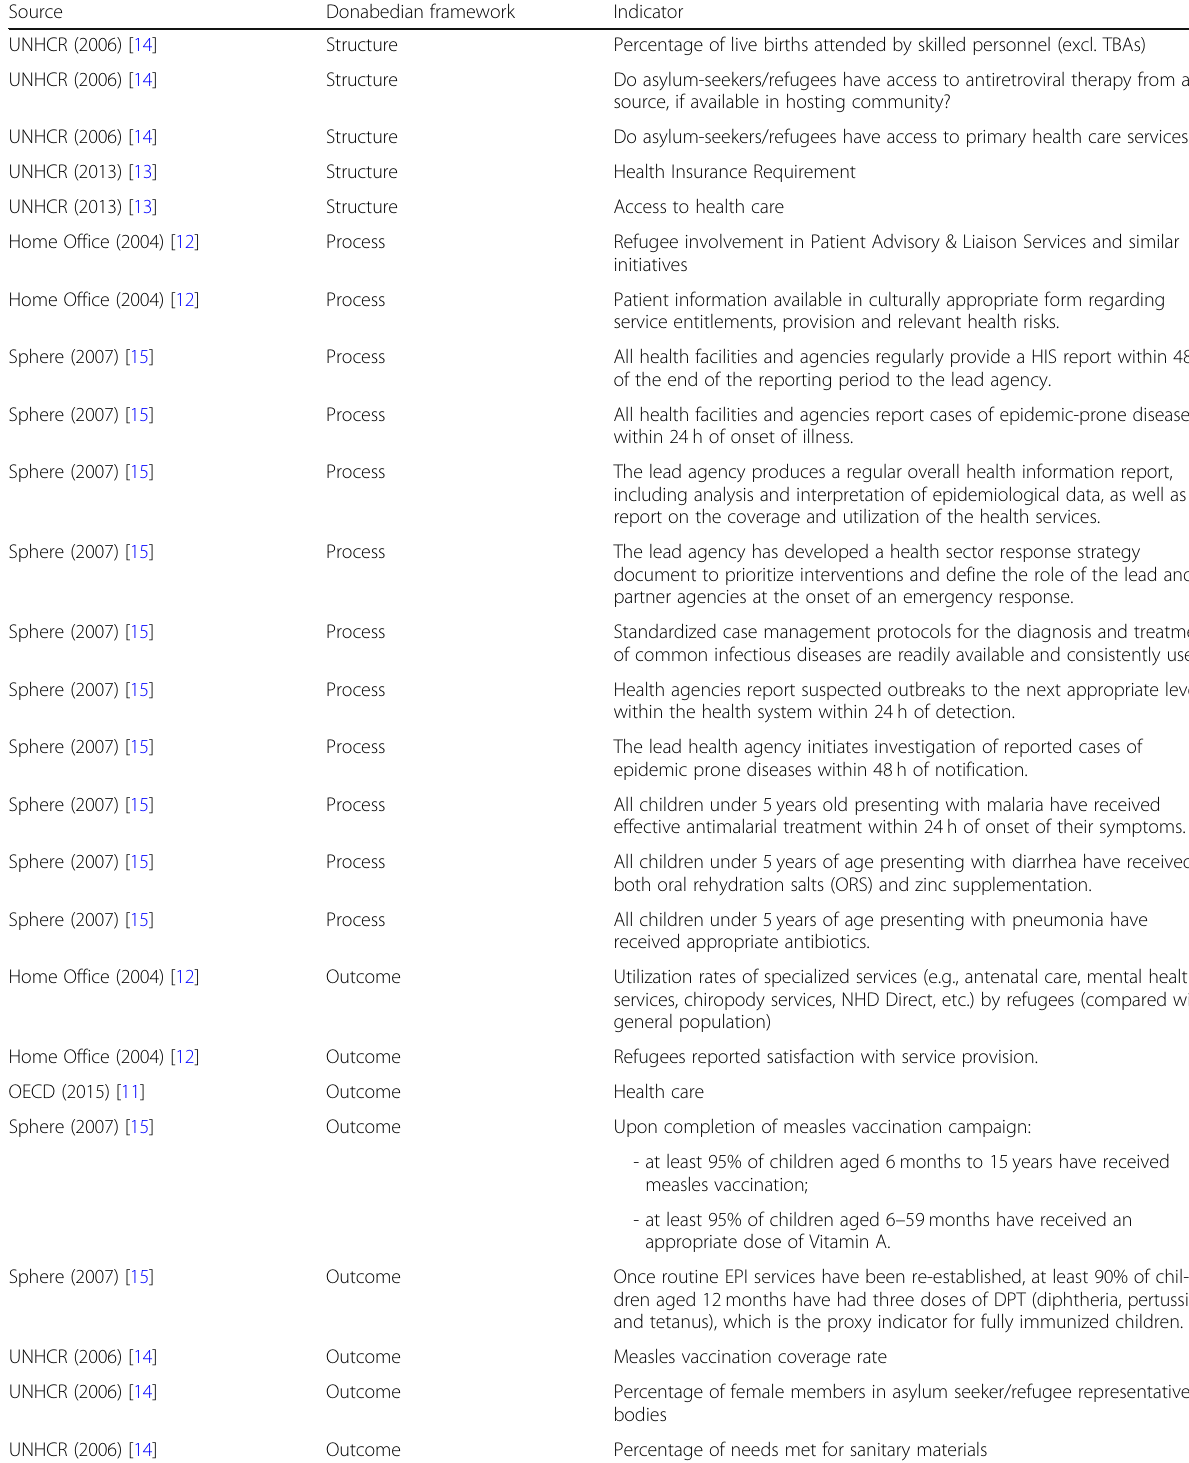
Table 3 Indicators for the topic health care services